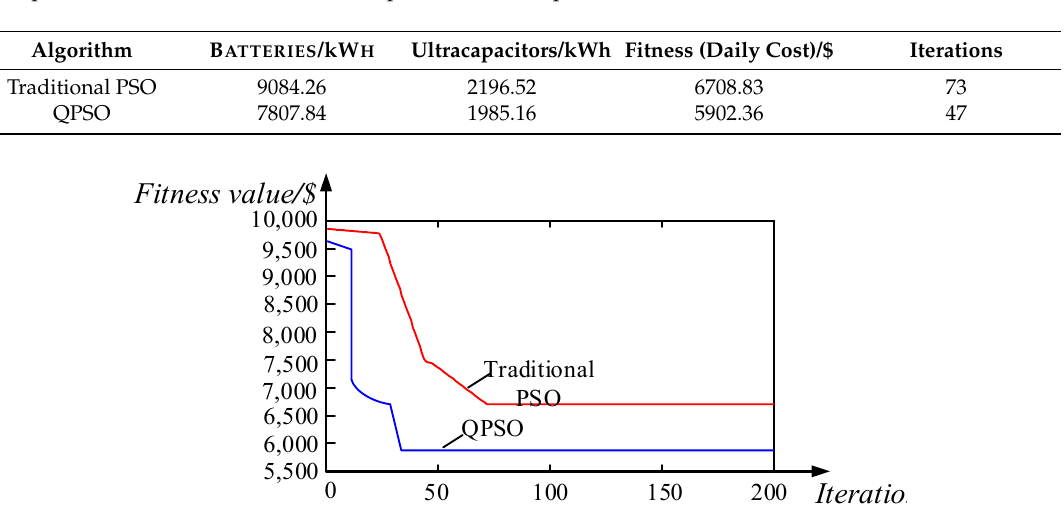
Table 2. Comparison of optimal configuration results using quantum-behaved particle swarm optimization (QPSO) and traditional particle swarm optimization (PSO).